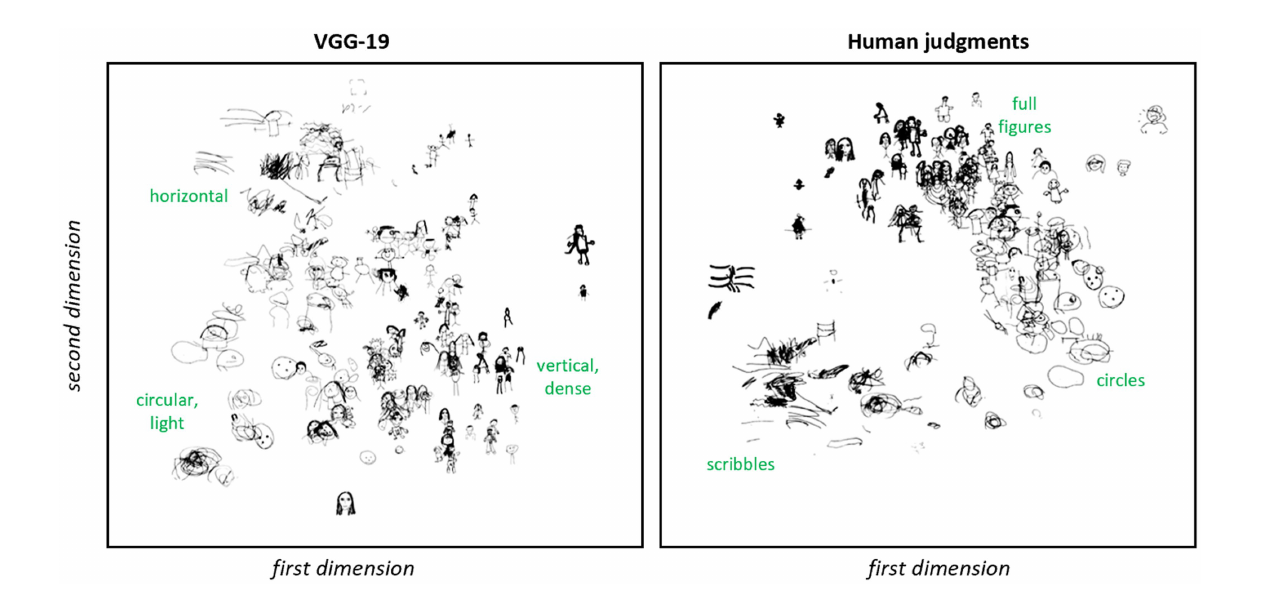
FIGURE 5 Two-dimensional embeddings of drawings. Two-dimensional embeddings for a subset of human figure drawings based on VGG-19 vectors (left) vs. human judgments of similarity (right). By inspection, each technique captures some aspects of structure. For VGG-19, circular shapes composed of light strokes are grouped in the bottom left, images with many horizontal strokes appear near the top, and drawings with dense strokes oriented vertically appear toward the right. For human judgments, sketches trace out a manifold reminiscent of a common developmental trajectory, with scribbles in the bottom left transitioning to circles toward the right and then to fuller depictions of the whole figure toward the top